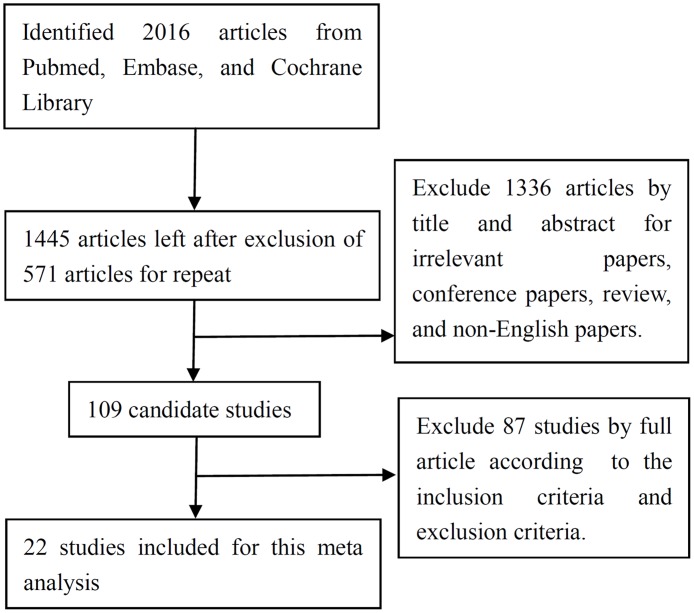
Flow chart of study selection for this meta analysis.